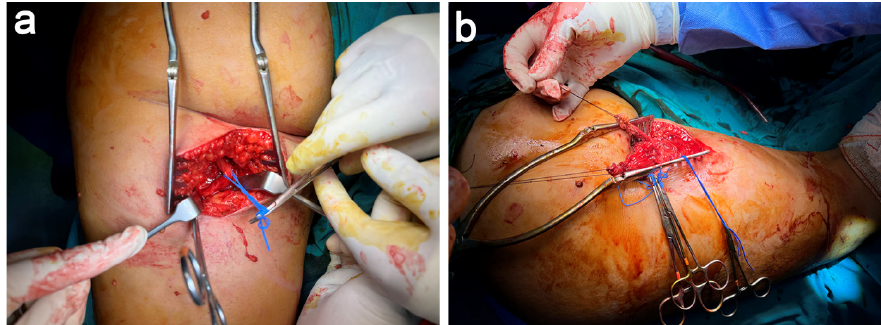
Figure 3. Dissection, neurolysis, and tenolysis ( a ) After exoneurolysis, the sciatic nerve is identified and placed laterally in the surgical field. ( b ) Following tenolysis, Vycril sutures are placed for traction on both tendons.